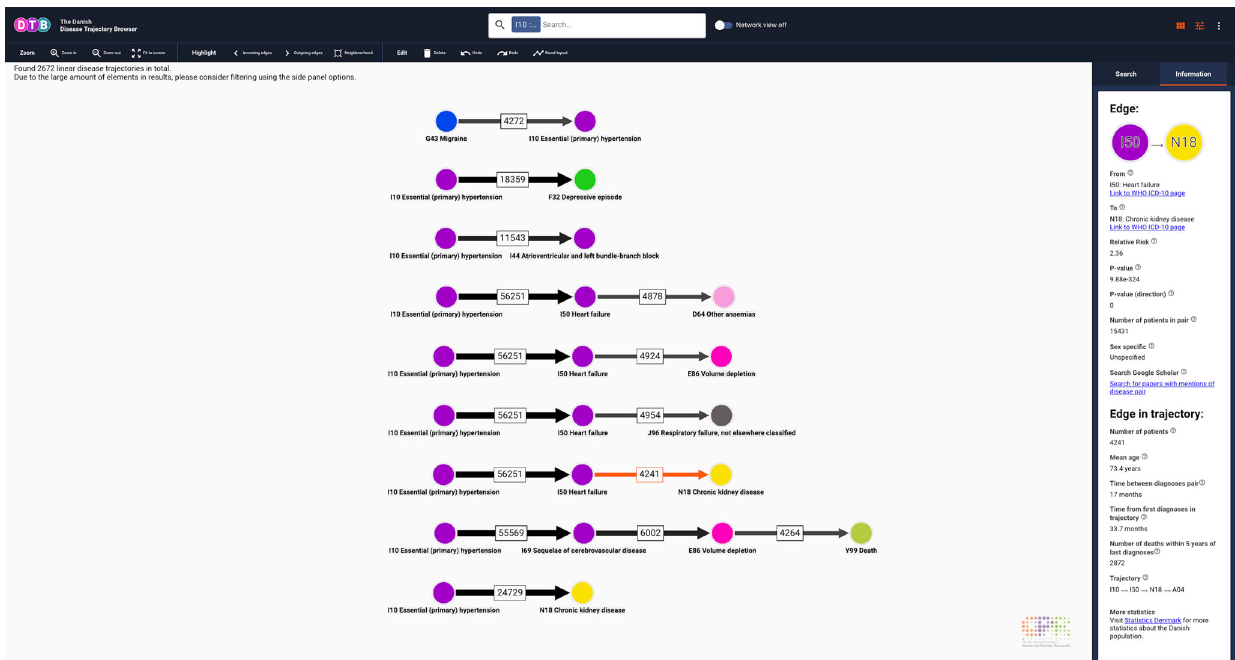
Fig. 4 Linear disease trajectories for essential (primary) hypertension (I10). When an edge is selected, users can explore characteristics for the entire trajectory and the individual trajectory edges separately. In this case, there are 56,251 patients who follow the trajectory I10 -> I50, 24,729 patients that follow the trajectory I10 -> N18 and 4241 patients who follow the trajectory I10 -> I50 -> N18 (visualisation interface). In the Information tab users can fi nd information on the selected length 2 trajectory as well as the entire trajectory (side panel). If users select a different edge or search for I50 or N18, the browser allows to compare e.g. mean age at assignment of fi rst trajectory across all statistically signi fi cant trajectories with RR > 1 in the entire population. Search fi lter settings: all patients, length 4 – 5, RR 1.15 – 361, number of patients 4000 – 114,099. I10: ICD-10 code for essential (primary) hypertension. I50: ICD-10 code for heart failure. N18: ICD-10 code for chronic kidney disease. ICD-10 International Classi fi cation of Diseases, 10 th Revision. Colours of nodes represent ICD-10 obtained by dragging with the mouse cursor while holding down the control-key (Windows/Linux) or command-key (Mac). Undo and redo buttons are available in the toolbar for simple corrections. Users can zoom in and out; either via the toolbar zoom buttons or directly by scrolling with the mouse wheel or trackpad.